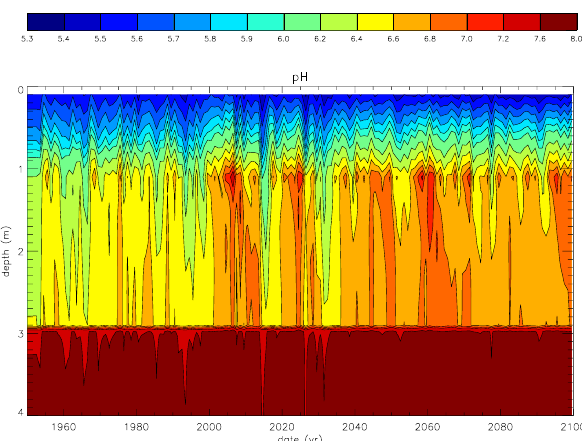
Fig. 6. Calculated soil solution pH plotted as a function of depth and time for the northern pedon.